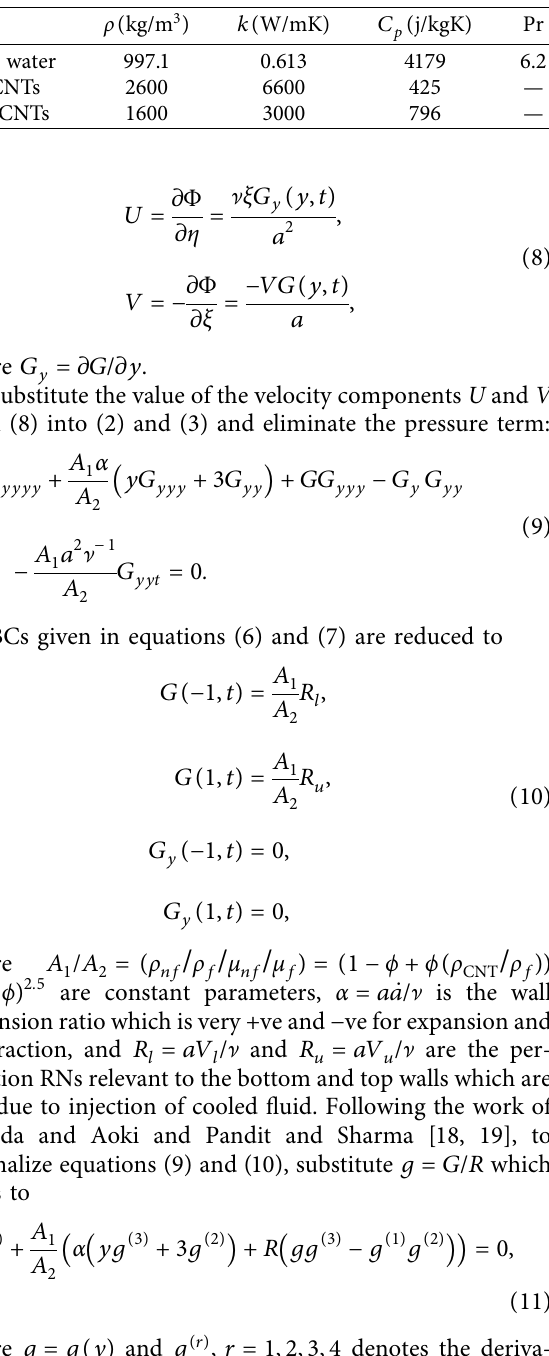
Table 1: Parameters of base fluid and